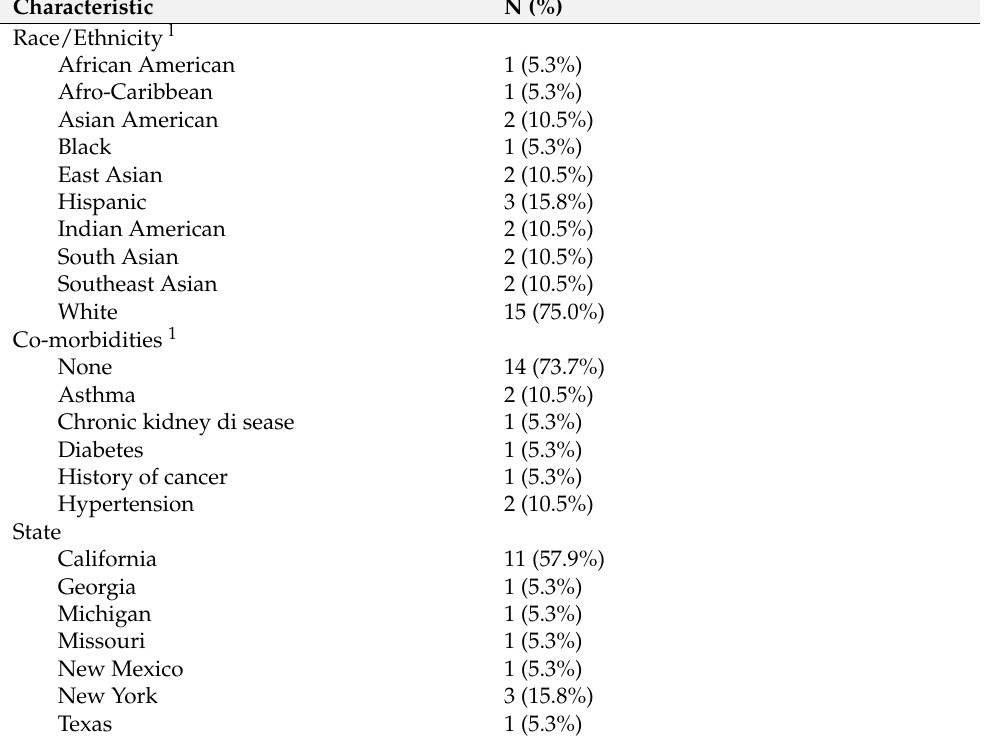
Table 1. Participant demographic